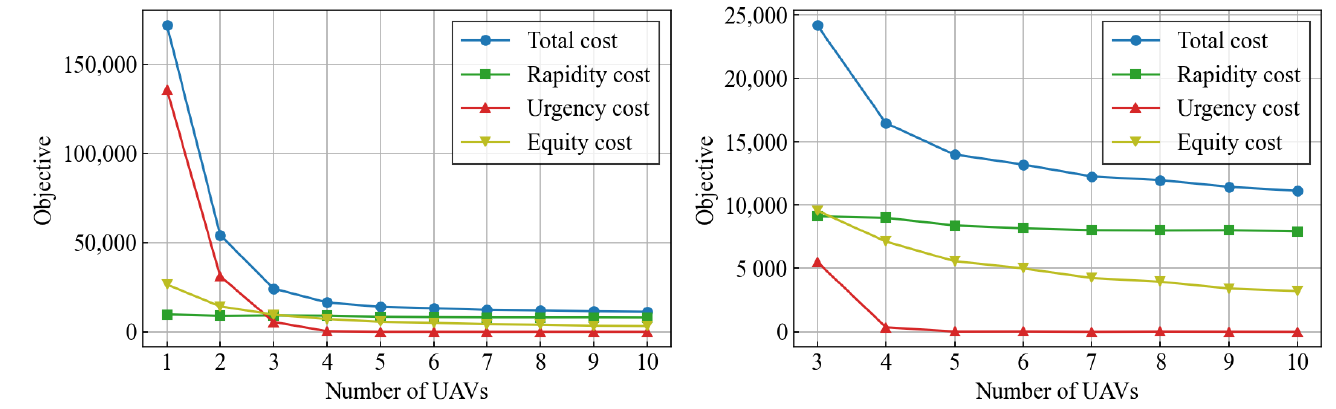
Figure 15. Minimum objective values for each number of UAVs in Scenario 1. ( left ) N U is from 1 to 10. ( right ) N U is from 3 to